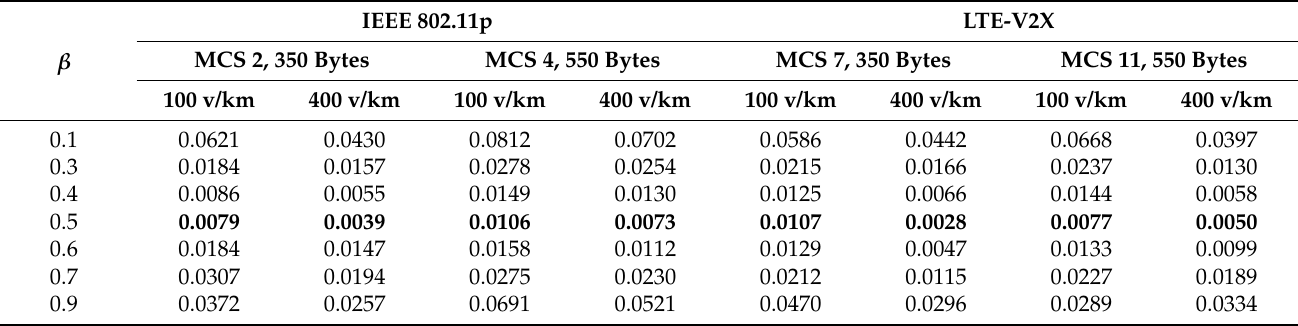
Table 2. Mean absolute error between the performance in terms of PRR vs. distance when comparing the use of the PER vs. SINR curve and the step function.